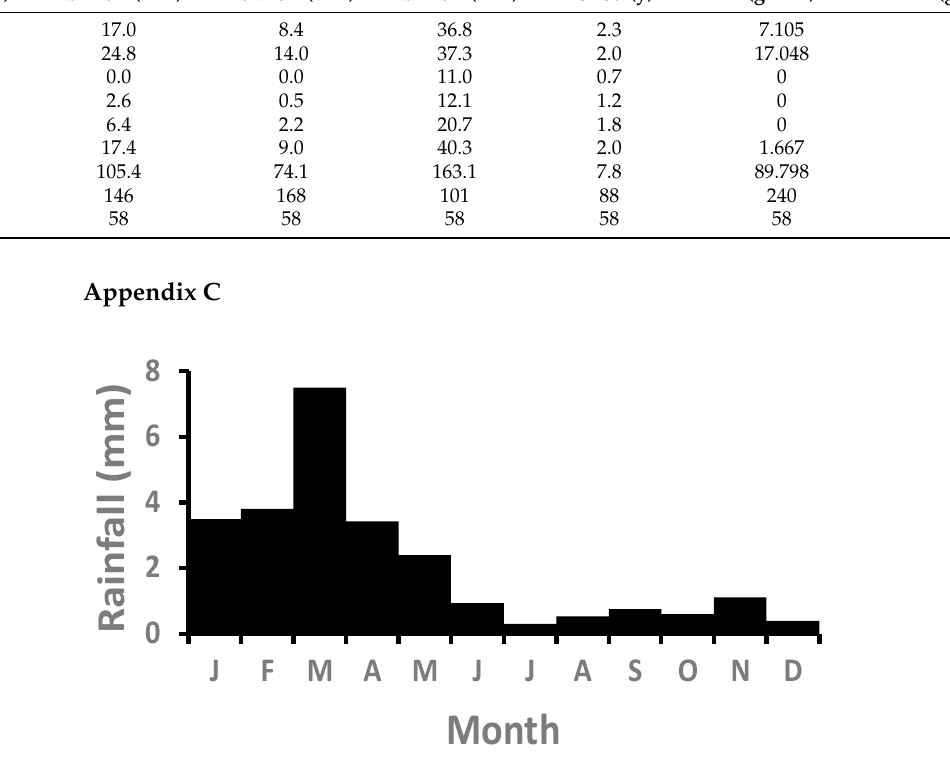
Figure A1. Average monthly rainfall (mm) at Gobabeb over 58 years.